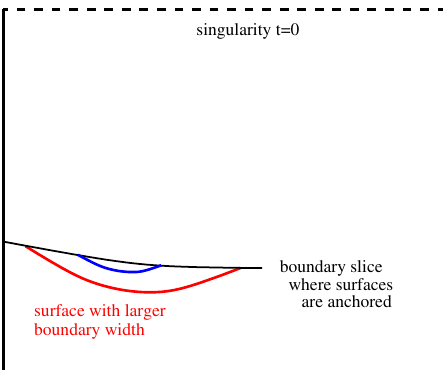
Figure 1 . Cartoon of extremal surfaces in AdS Kasner, anchored on a boundary time slice (black curve). For small width (blue), the surface stays close to the boundary, while for large size (red), the surface dips deeper into the bulk. These bend away from the singularity (dotted